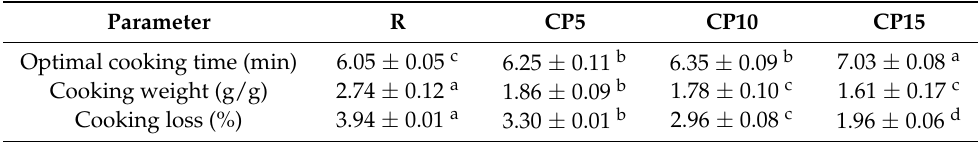
Table 3. Cooking properties of durum wheat pasta enriched with cricket